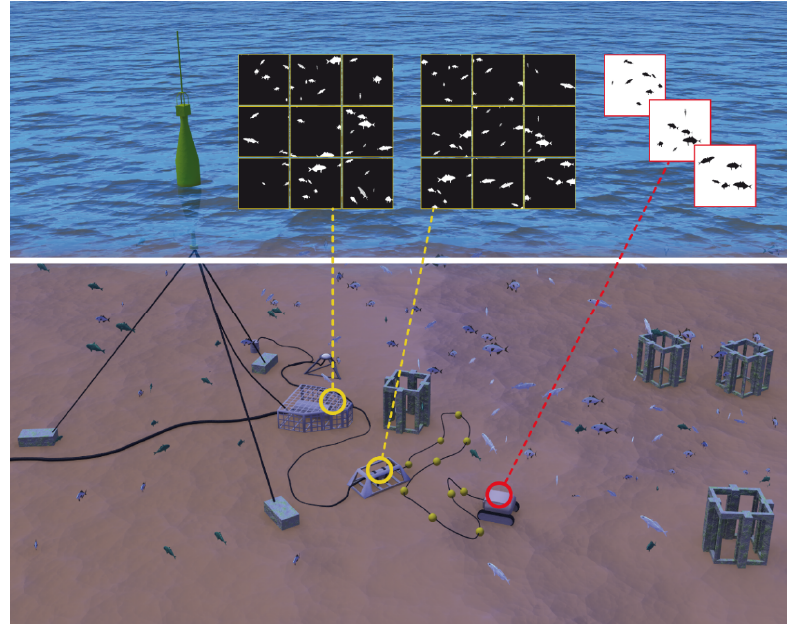
Figure 2. Schematised global view of the OBSEA monitoring area with artificial concrete columns for its protection from illegal hauling. Circles indicate the fixed (yellow) and mobile crawler (red) cameras and arrows represent their time-lapse (fixed) or continuous footage-based imaging (with fish silhouees in the above images as an example of the different individuals and species). Notably, the second fixed camera mounted on a satellite tripod was not operational at the time of crawler deployment and testing.